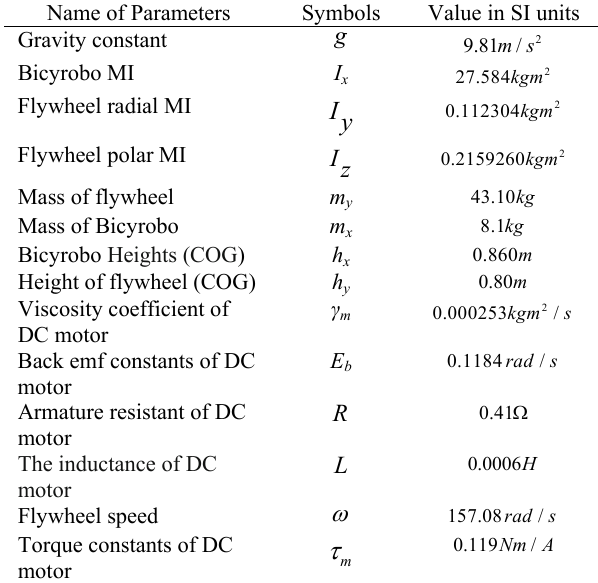
Table 2: Value of the bicyrobo Parameters Name of Parameters